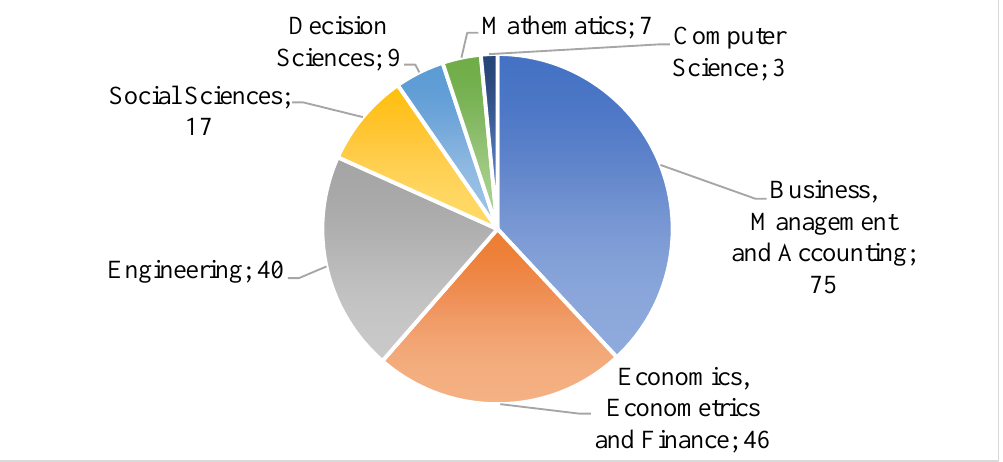
Fig. 3. Number of documents by subject area.